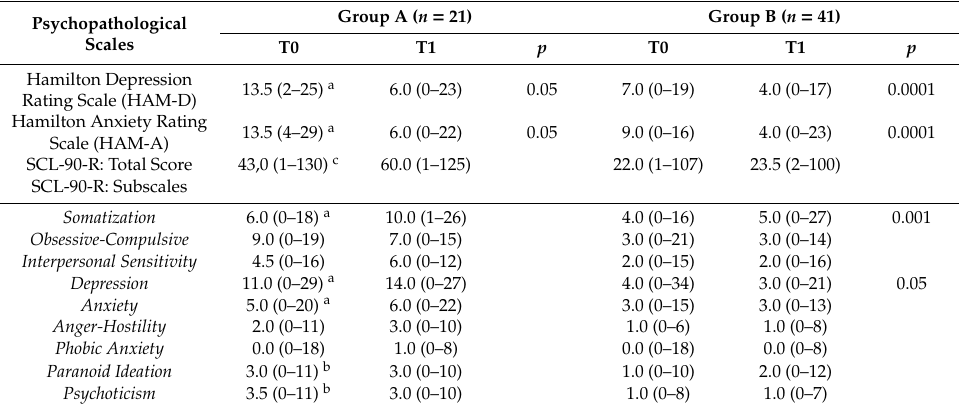
Table 2. Median scores and ranges (min–max) of psychopathological scales in CHC patients with (Group A) and without (Group B) a current or lifetime psychiatric history, before (T0) and 12 weeks after completing treatment with direct-acting antiviral (DAA) agents (T1).